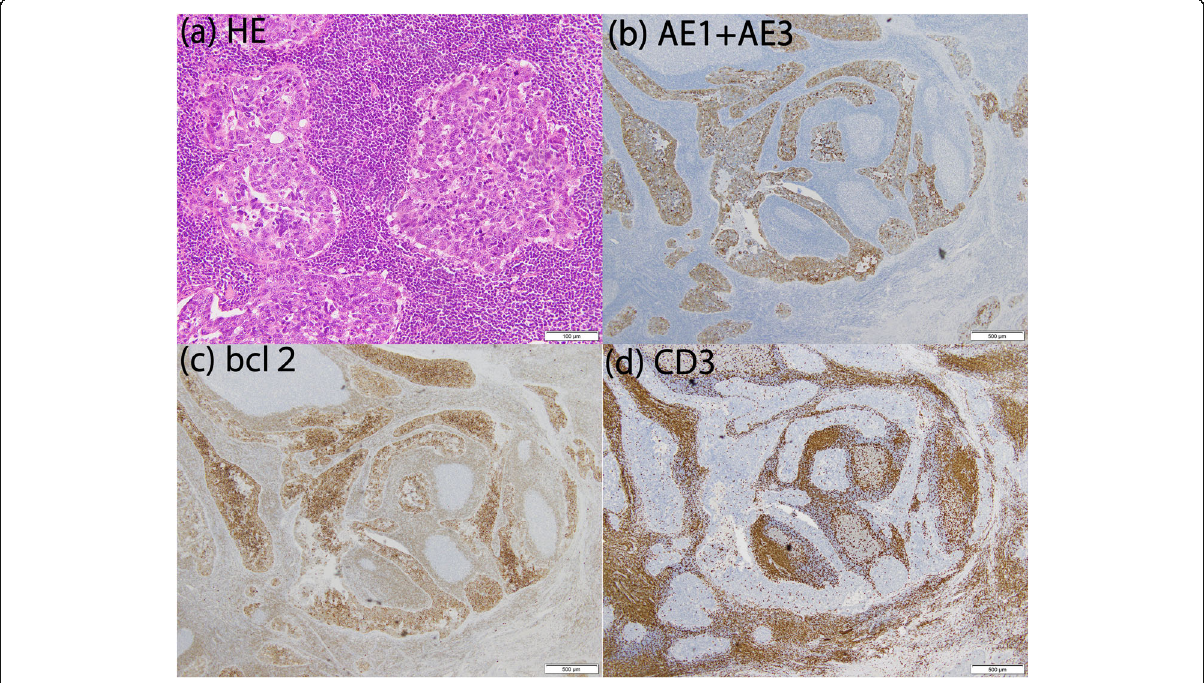
Fig. 1 Case 1. Results of HE staining and immunohistochemical analysis. a HE staining showed that the tumor cells had edematous large and round nuclei and formed a solid corded net on the background of dense lymphocyte infiltration. Thymic disease was positive for b cytokeratin AE1 + AE3 and c Bcl2, while infiltrated lymphocytes were positive for d CD3 and CD5 and negative for